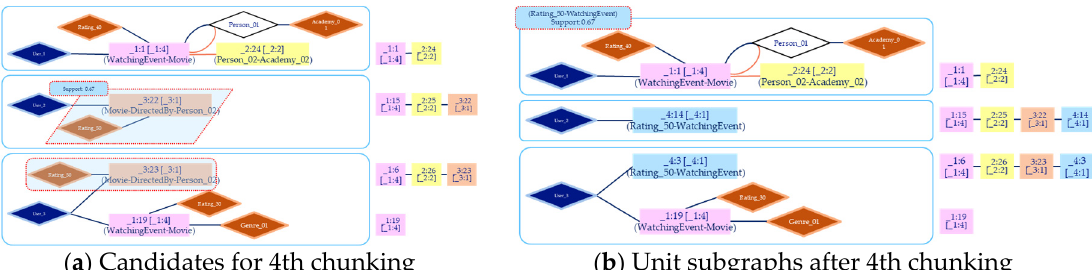
Figure 15. 4th candidate generation and chunking result.